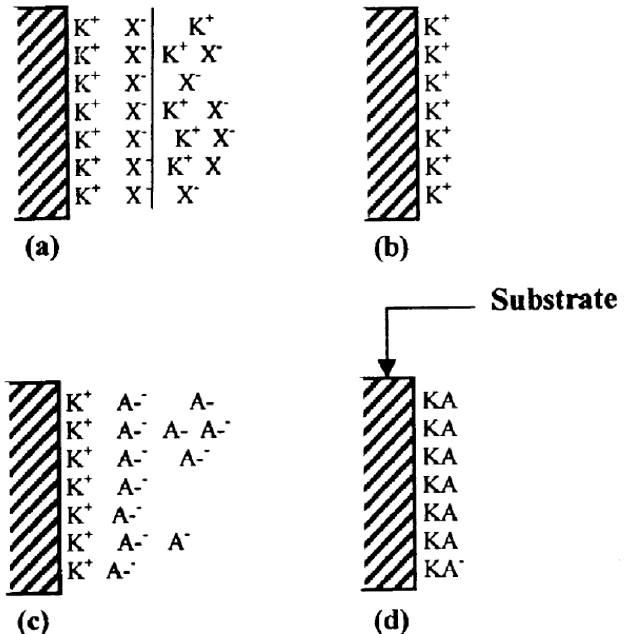
Figure 9. Schematic diagram of SILAR growth. ( a ) Adsorption of K + X − and the formation of electrical double layer, ( b ) first rinsing to remove excess, unabsorbed K + and X − , ( c ) reaction of A − with pre-adsorbed K + ions to form KA, and ( d ) second rinsing to remove excess and unreacted species and form the solid solution KA on the surface of the substrate. Reproduced with permission from